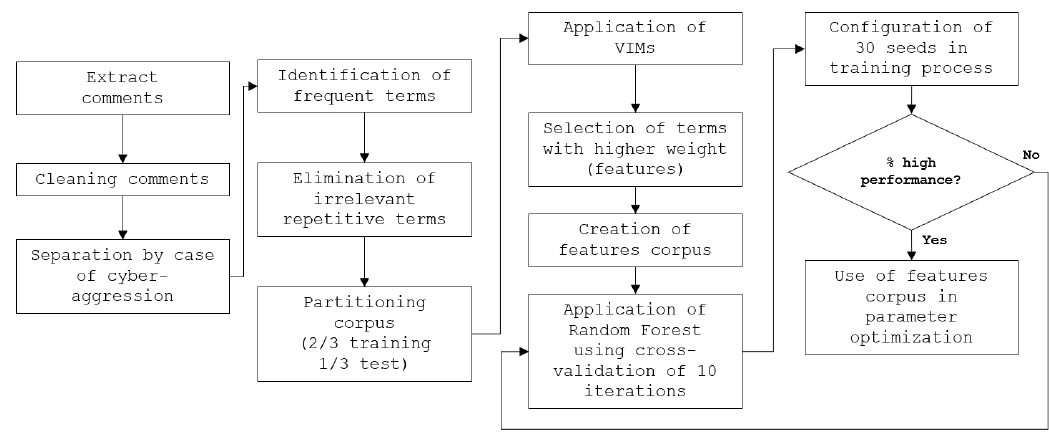
Figure 2. Feature-selection